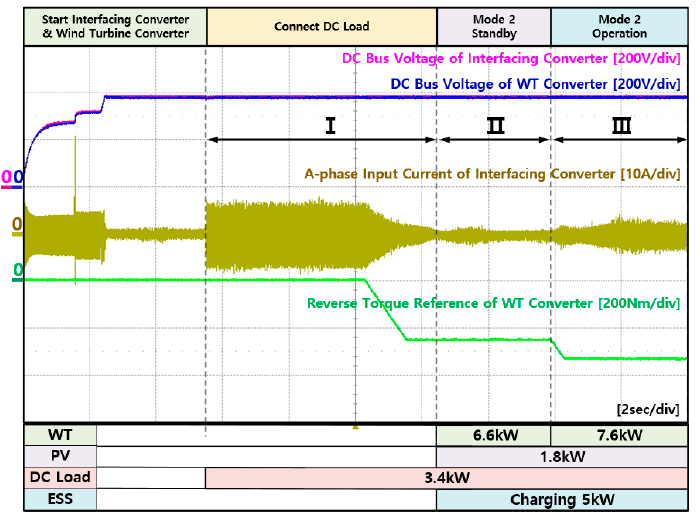
Figure 14. Experiment waveforms of interfacing converter and WT converter in mode 2.